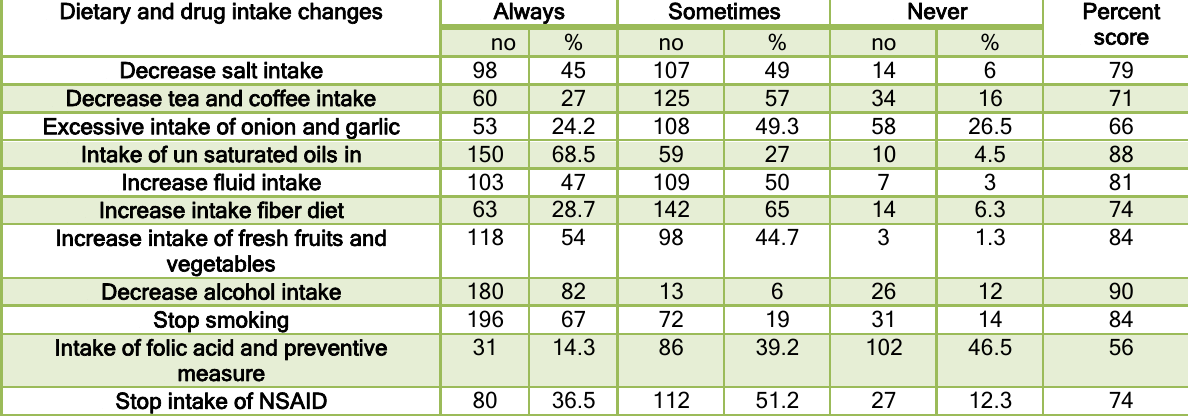
Intake of un saturated oils in